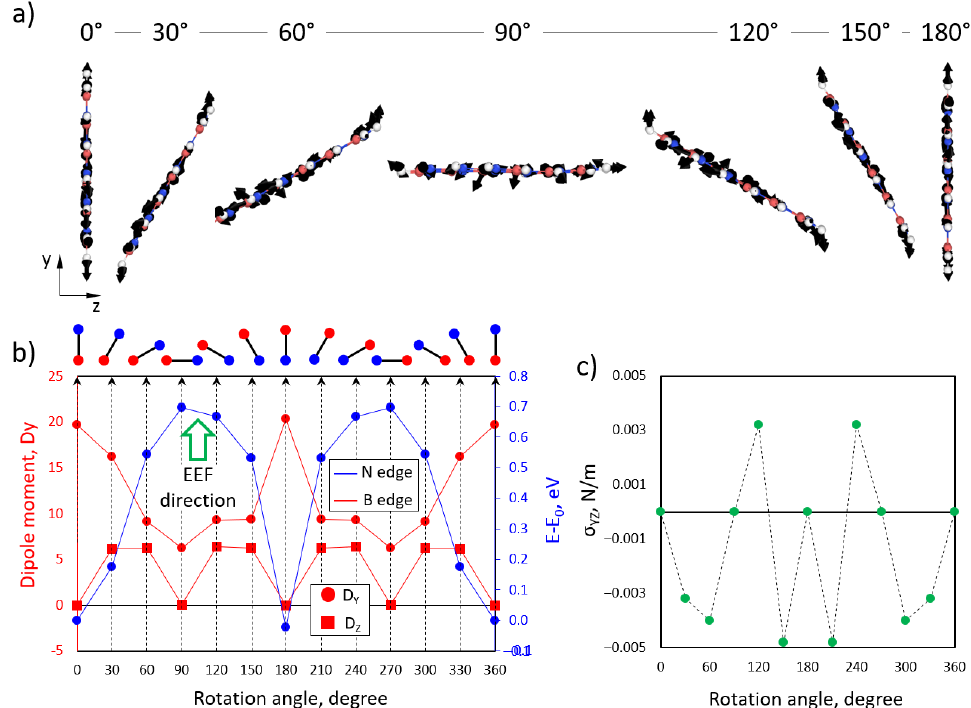
Figure 10. ( a ) Side view of the atomic structure of BN flakes with calculated atomic forces (black arrows) under the influence of an EEF. ( b ) Dependence of the y-component (red circles) and the component (red rectangles) of the BN flake dipole moment and total energy (blue dots) on the rotation angle in the yz direction. ( c ) Dependence of the yz components of the mechanical stress tensor on the rotation